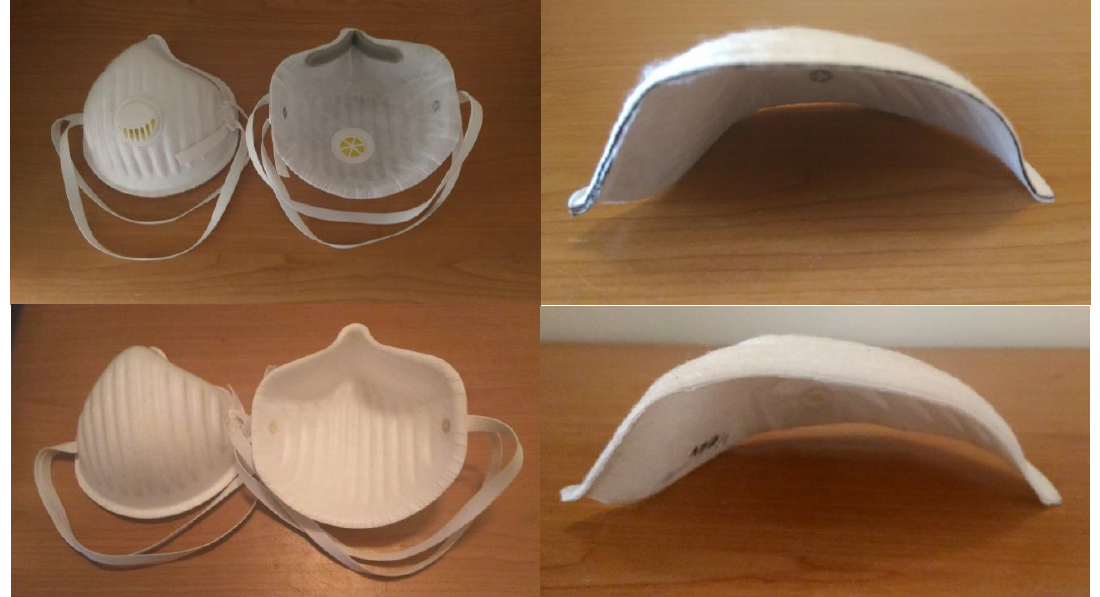
Figure 13. Example of respirators that were made with ( up ) and without ( down ) an adsorption layer. The left is the top and bottom view of the respirators (with or without valve). The right is a cut through of these respirators, with the view though the construction layer. From the top there is bicotextile, adsorption textile, nanofibers filtration membrane, and bicotextile.